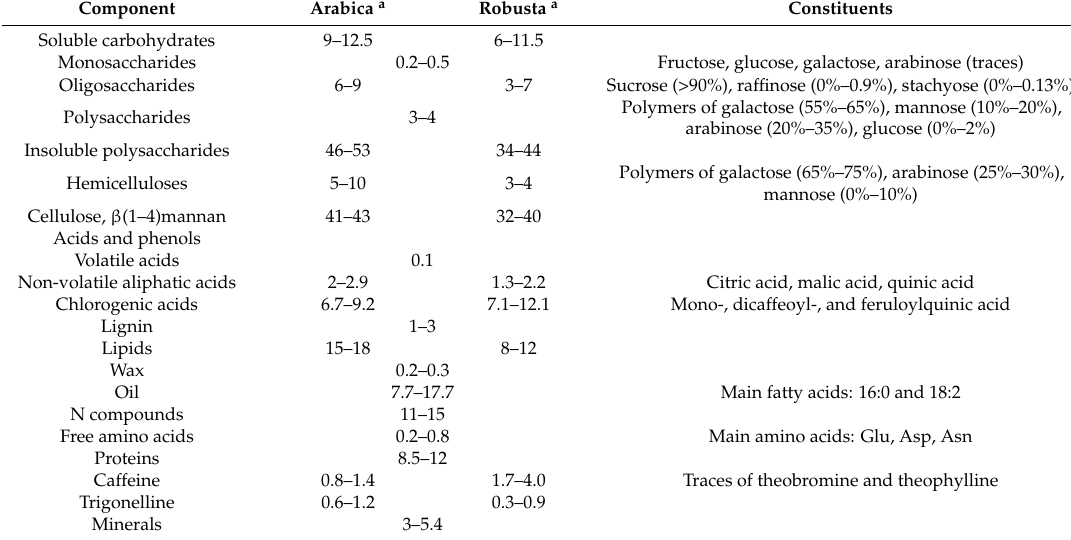
Table 1. Chemical composition of green coffee (varieties C. arabica and C. robusta ).